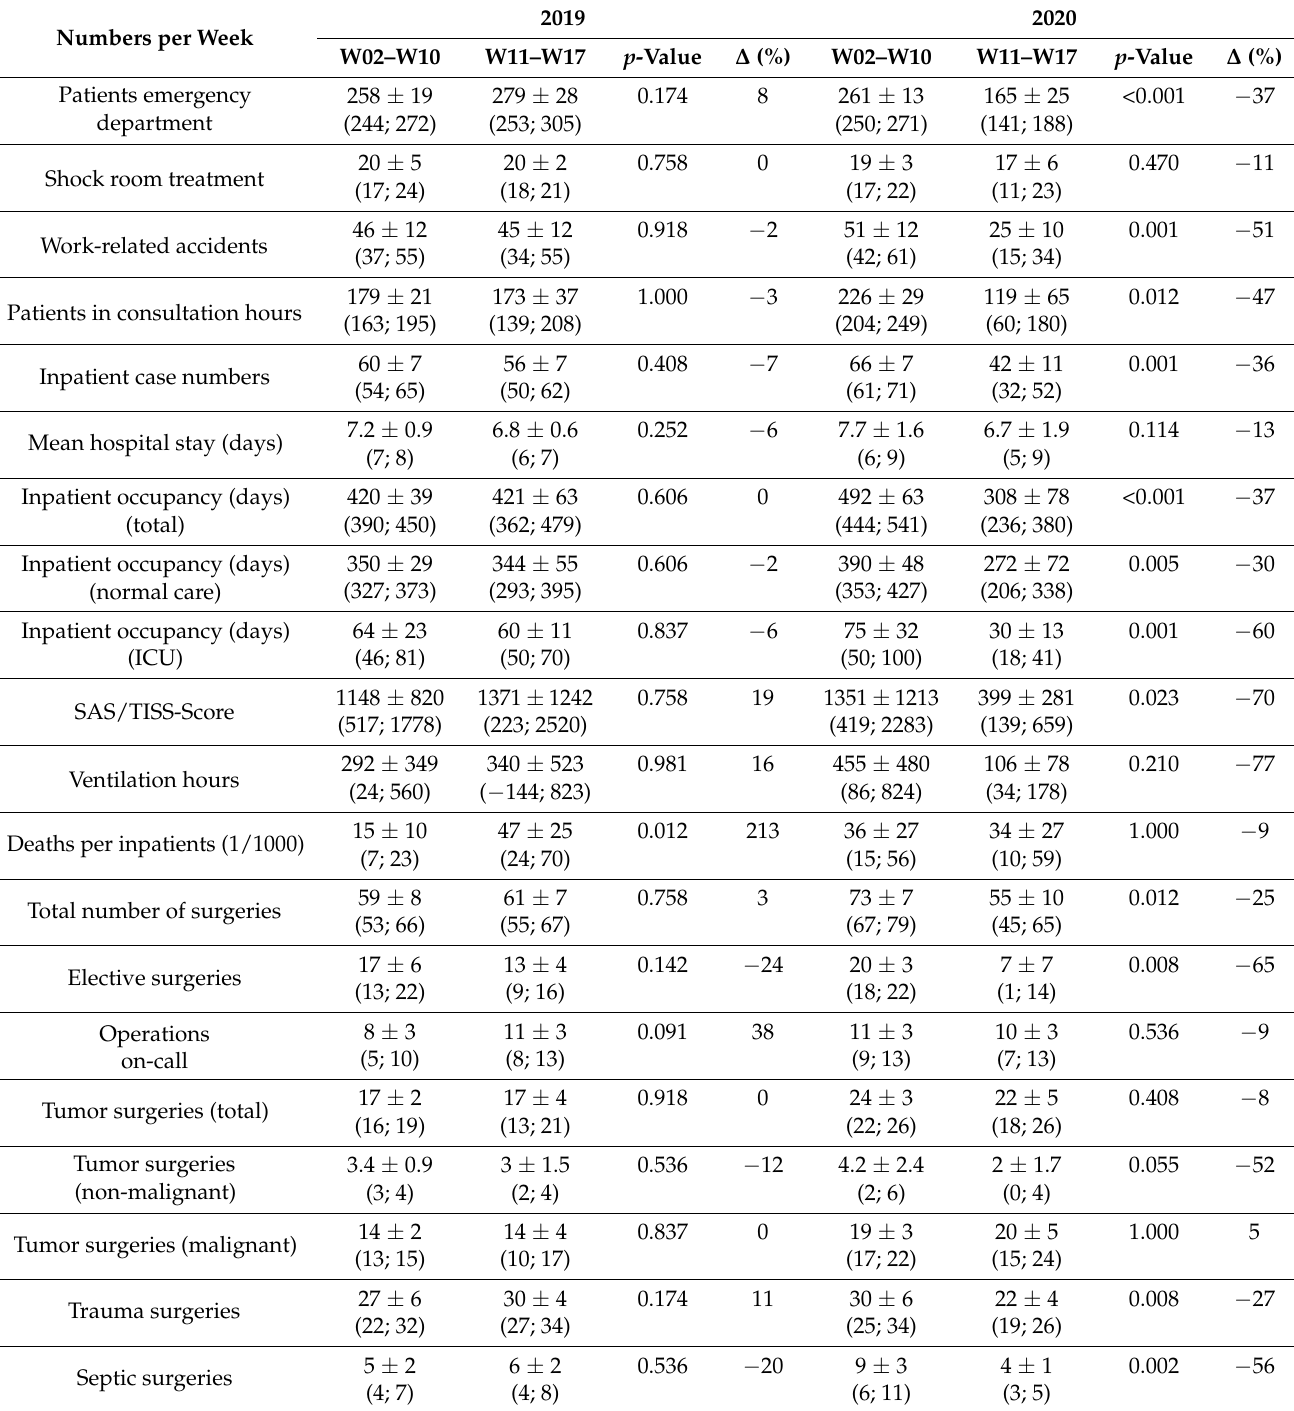
Table 1. Descriptive statistics of the investigated consultations and cases with mean ± standard deviation, 95% confidence interval, and p -values of weeks 02–10 vs. weeks 11–17 of 2019 and 2020. Statistical difference of the non-paired and non-parametric values was determined by the Mann–Whitney U test. In addition, the difference in the mean values between weeks 02–10 vs. weeks 11–17 was determined as ∆ (%) of